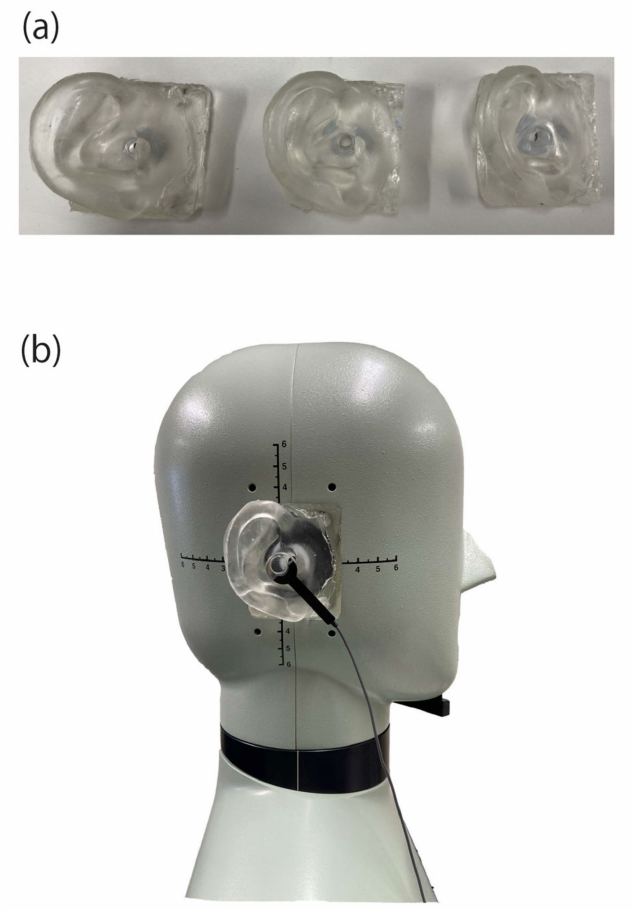
Figure 2. ( a ) Developed pinna simulators (A10, A20, and A40 from the left) and ( b ) embedded pinna simulator in the HATS and position of the cartilage conduction transducer at the entrance of the external auditory